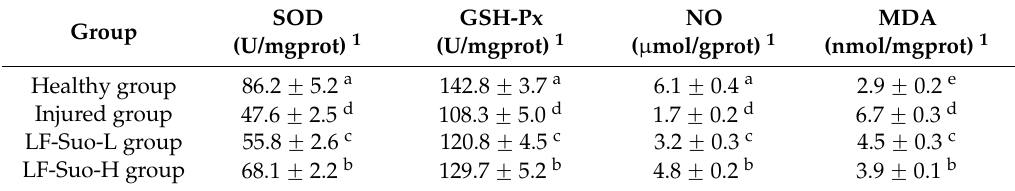
Table 6. Gastric tissues SOD, GSH-Px, NO and MDA activities of studied